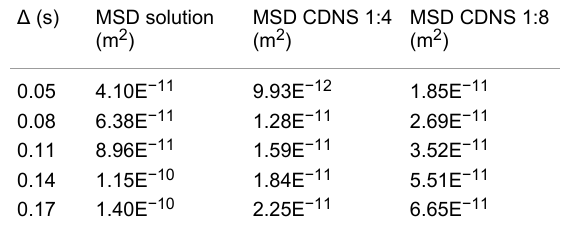
Table 2: MSD (m 2 ) of IP dissolved in: solution, CDNSEDTA (1:4) and CDNSEDTA (1:8) gel system at variable observation time t d (s). Esti- mated experimental errors: 0.5% for the solution, 1.6% for CDNS 1:4 and 2.3% for CDNS